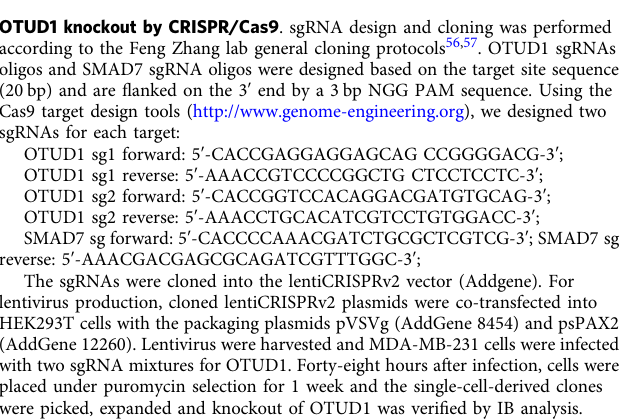
Primer2-Reverse: AATTCAAAAAGC TCAGCAATGGACACTATGACTCG